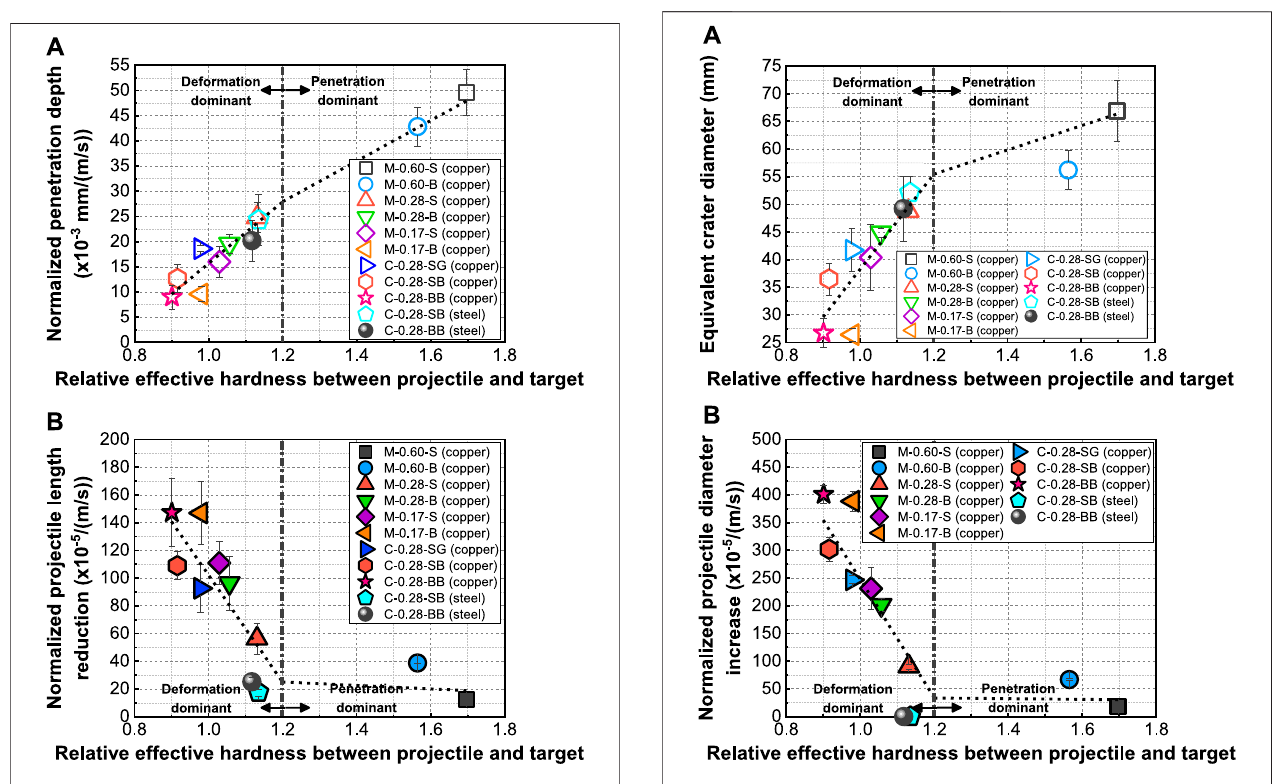
FIGURE 16 | Variation of (A) the CD and (B) the projectile diameter increase with respect to the